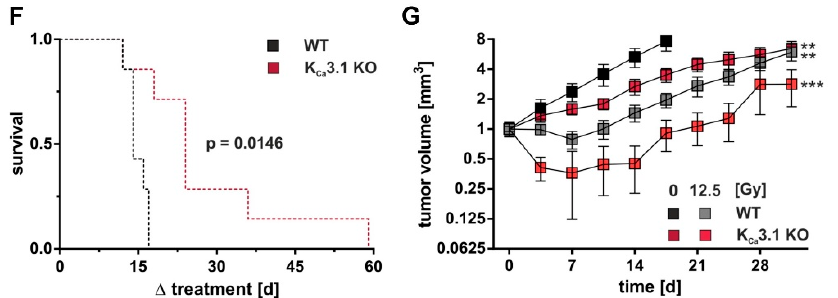
Figure5. K Ca 3.1channelsconferradioresistancetoMMTV-PyMTbreastcancerin vivo. Computer-aided depiction of the irradiation setup used to locally irradiate the breast tumors. Part ( A ) represents the radiation beam (yellow gold-colored) produced by a linear accelerator and the lead shieldings. The beam is trimmed by the shielding satellite to a rectangular miniature beam which then reaches the tumor. ( B ) Beam, mouse holder, and 2nd on-body shielding in higher magnification. ( C ) Film dosimetry recorded in the coronal plane of a mouse phantom during application of 5 Gy with the setup described in A,B. Drawings of mouse and holder are superimposed. Dose distribution is given in pseudo colors. ( D ) Kaplan-Meier curves and ( E ) individual (symbols) and median (line) survival time ( n = 7) of FVB / N mice orthotopically transplanted with MMTV-PyMT WT (black / gray) or K Ca 3.1 KO (red) cells and treated with 5 fractions for a total dose of either 0 Gy (black, dark red) or 12.5 Gy (gray, bright red) starting at a tumor size of 5 mm. Compared to WT 0 Gy or 12.5 Gy, survival time was significantly prolonged in accordingly treated mice bearing K Ca 3.1 KO tumors with one complete responder (CR) in the ionizing radiation group. *, **, and *** indicate p 0.05, p 0.01 and p 0.001. Survival statistics ≤ ≤ ≤ in ( E ) are calculated from Kaplan-Meier curves in ( D ) by log-rank test with Bonferroni correction. ( F ) Kaplan-Meier curves showing radiation-mediated survival benefit for both genotypes as calculated by survival benefit = 1 (survival 12.5Gy survival 0Gy ). Normalized to non-irradiated controls was − − performed to present in detail the survival benefit of the respective genotypes from IR. The indicated p value was calculated by log-rank test. ( G ) Mean tumor volume ( SE, n = 7) normalized for each mouse ± to the volume at treatment start is plotted against the time for control (0 Gy, gray and bright red) and 12.5 Gy-fractionated irradiated (black and dark red) K Ca 3.1 WT (gray, black) and KO (bright and dark red) tumors. Two-way ANOVA and Tukey´s test compared to WT 0 Gy with ** and *** indicative for p 0.01 and p 0.001. ≤ ≤